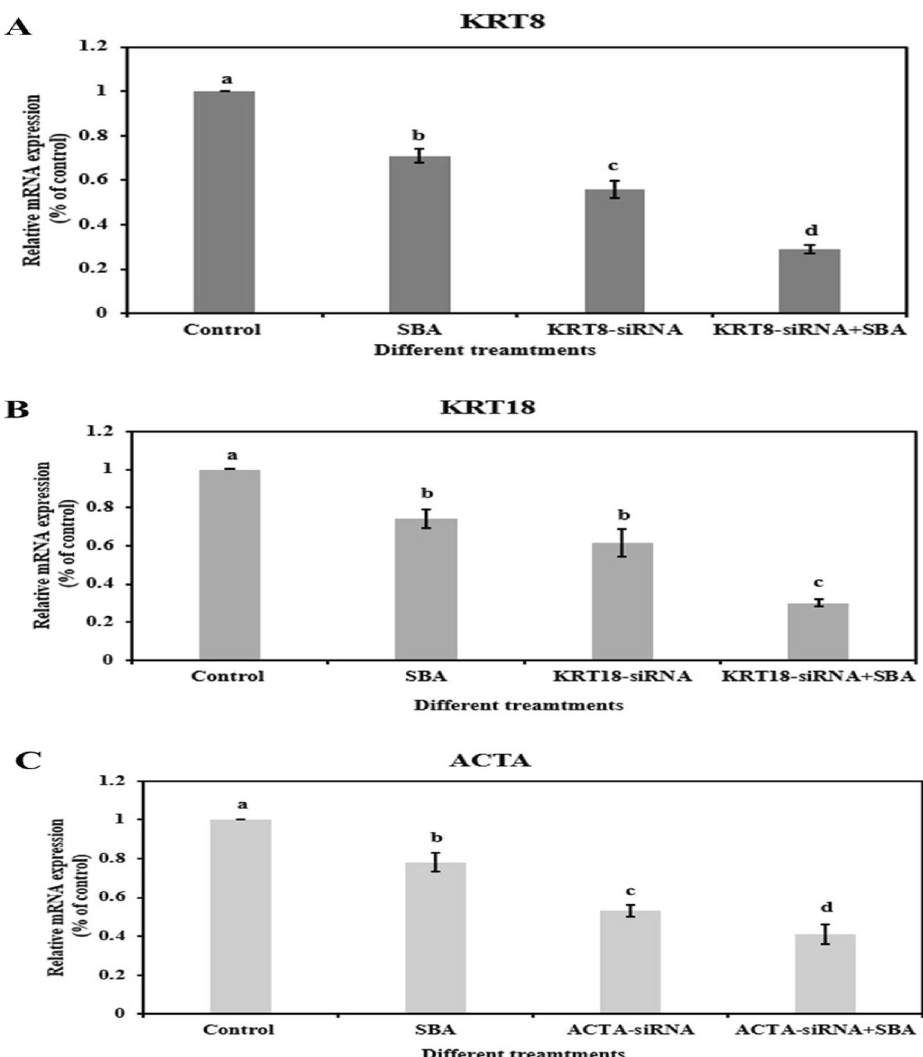
Figure 6. ( A – C ). The relative mRNA expression level of KRT8, KRT18, and ACTA in different treatments. IPEC-J2s were treated with 0.0, 2.0 mg/mL SBA, cytoskeletal protein gene silencing (KRT8, KRT18 and ACTA) treatment and cytoskeletal proteins (KRT8, KRT18, ACTA) gene silencing + SBA treatments for 24 h. The gene expressions of KRT8, KRT18 and ACTA were measured by quantitative RT-PCR. GAPDH was used as an internal control. ( A ) Keratin 8 mRNA expression in different treatments; ( B ) Keratin 18 mRNA expression in different treatments; and ( C ) Actin mRNA expression in different treatments. Data are represented as mean ± SEM. Different lowercase letters are significantly different ( p <